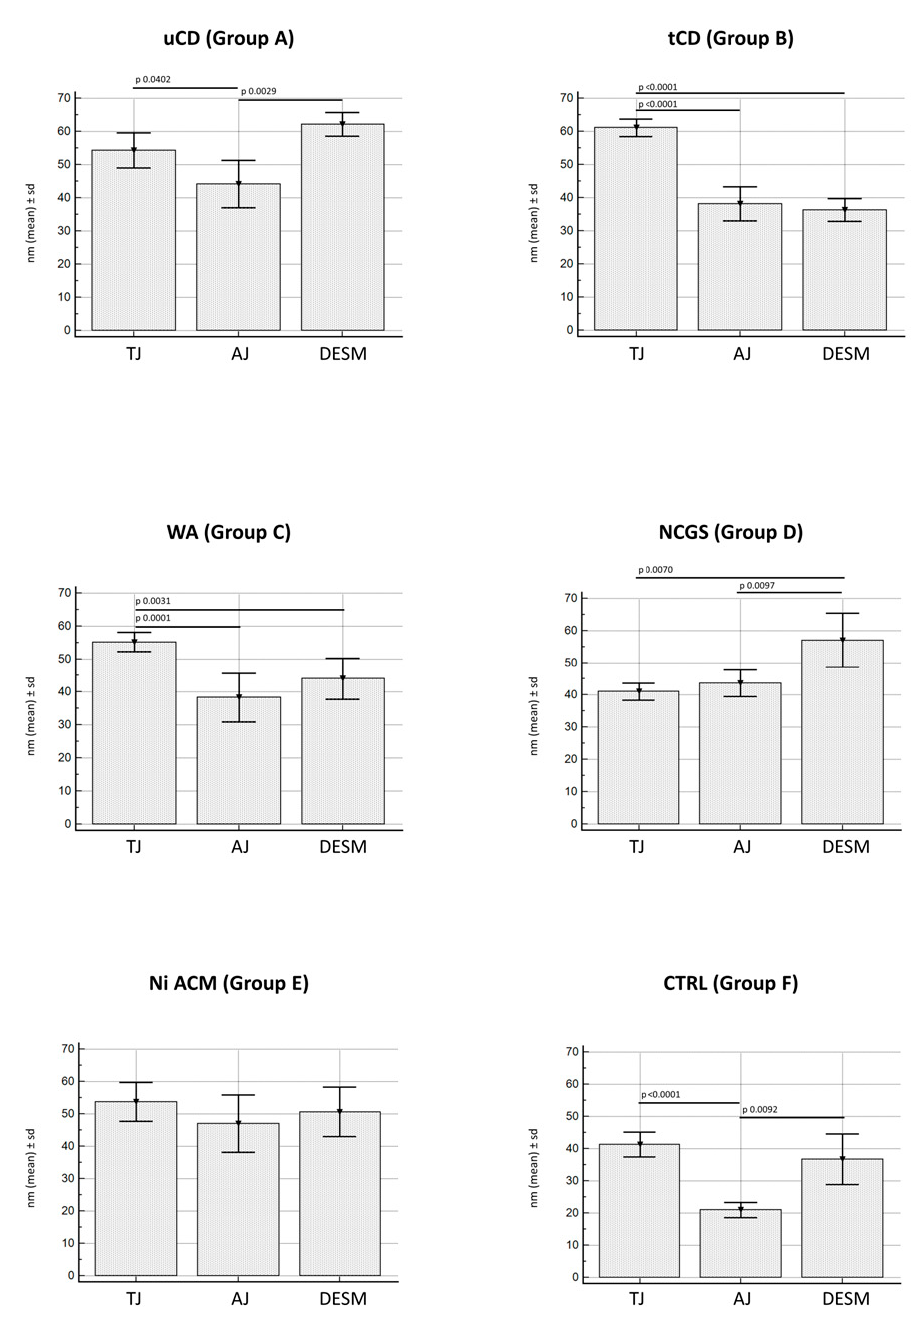
Scheme 2. ( a ). Distances between apical junctional complexes (AJC) in the different groups under study, divided by single component (TJ, AJ, and desmosomes). Legend: uCD, untreated celiac disease; tCD, treated celiac disease; WA, wheat allergy; NCGS, non-celiac gluten sensitivity; Ni ACM, Nickel allergic contact mucositis; CTRL, controls. ( b ). Distances between the single components of the apical junctional complexes (AJC) (TJ, AJ, and desmosomes), in the different groups under study. Legend: uCD, untreated celiac disease; tCD, treated celiac disease; WA, wheat allergy; NCGS, non-celiac gluten sensitivity; Ni ACM, Nickel allergic contact mucositis; CTRL, controls.